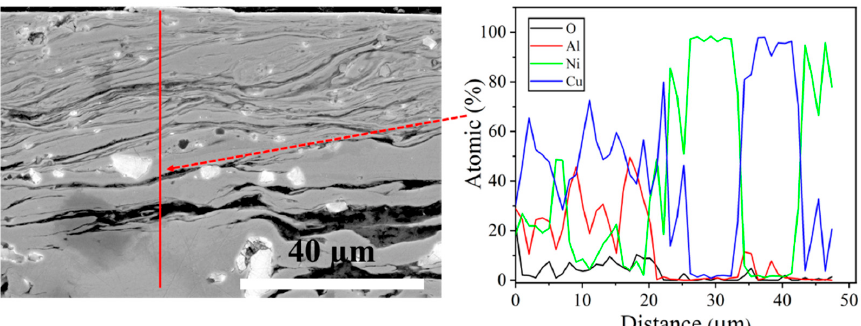
Figure 7. EDS line mapping showing the elemental distribution across the interface of the FSP region and the unprocessed FSP-S2 coating.